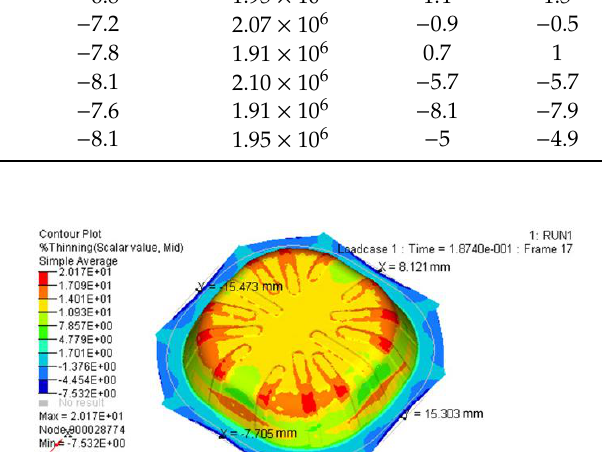
Figure 11. % Thinning distribution and X1, X2, Y1 and Y2 values for the RUN1; blank1.